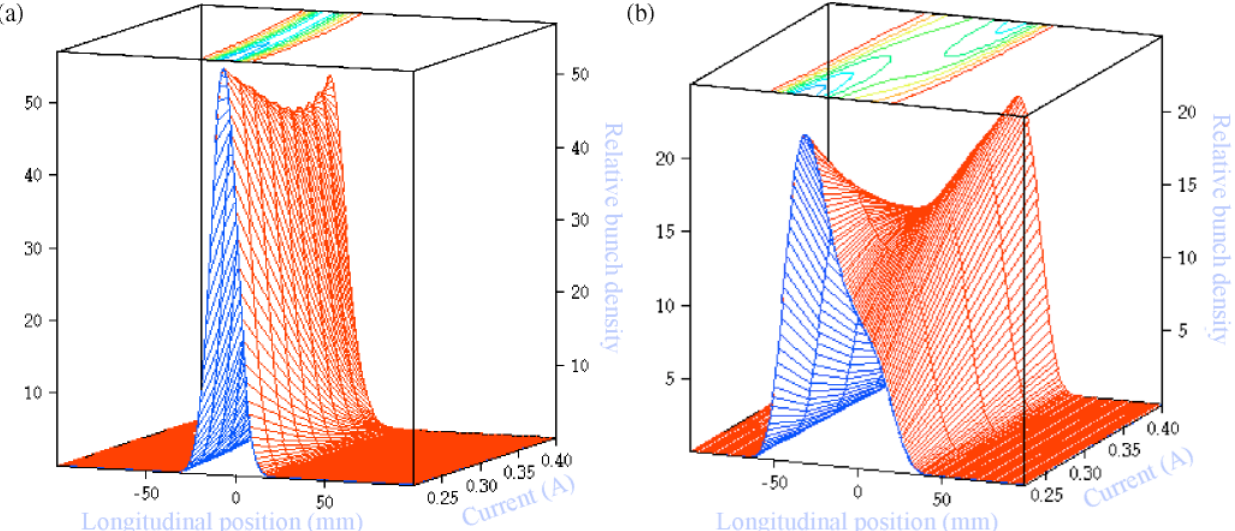
FIG. 7. (Color) (a) Evolution of the bunch shape over a fill for the case of a fixed detuning at 330 kHz. The bunch shape and phase change much less than for the case of a constant voltage but with a lower increase in integrated current. (b) Fixed voltage of 360 kV. The bunch phase slips forward and behind the synchronous phase above and below the current where the maximum bunch length